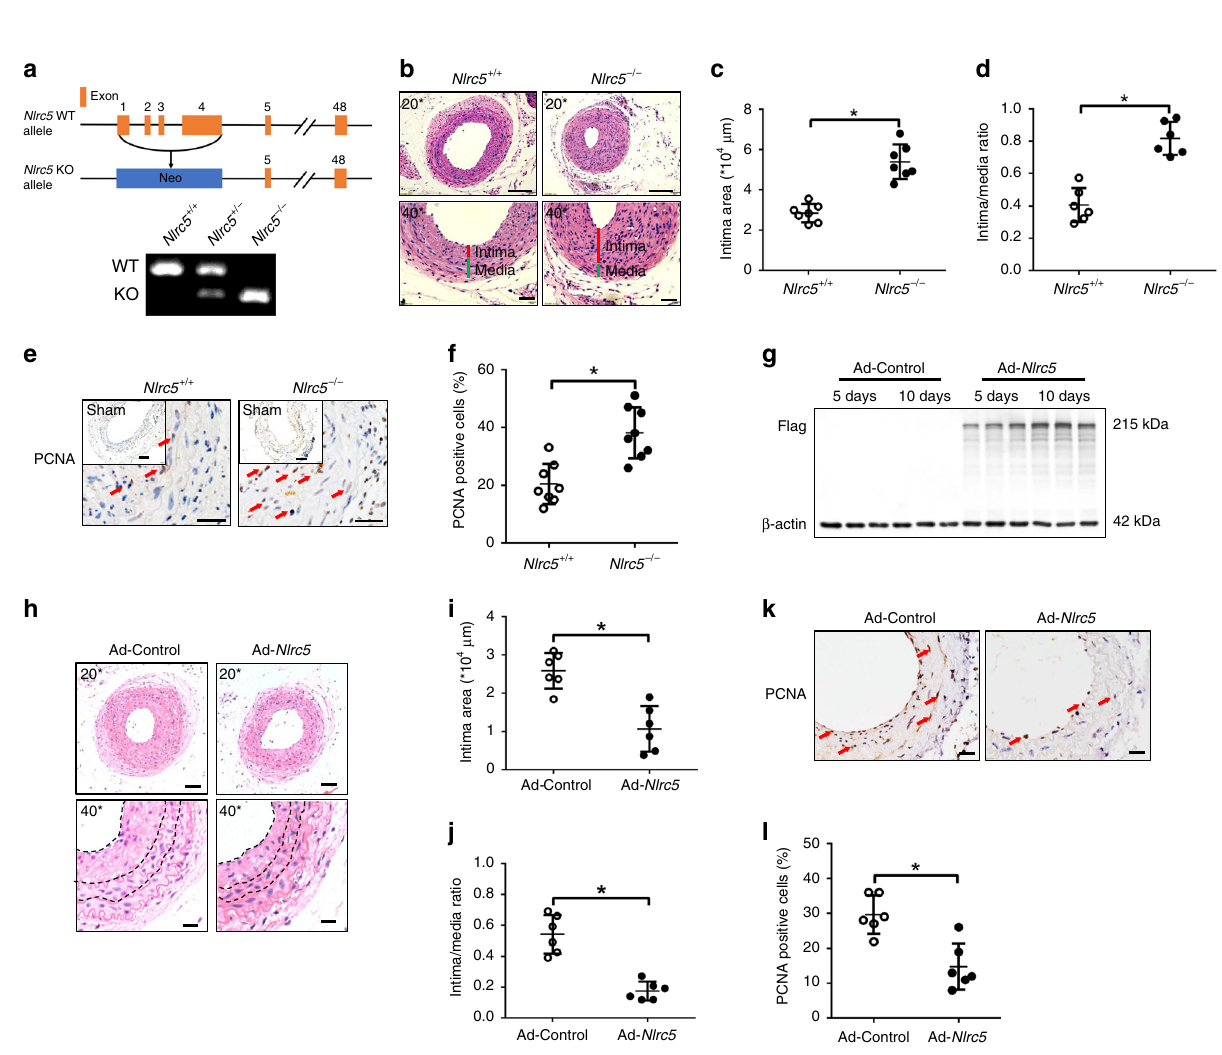
Fig. 1 NLRC5 is upregulated in human coronary plaque and in mouse ligated carotids. a Representative images of hematoxylin/eosin-stained normal coronary artery and coronary plaque. Scale bar: 100 μ m. b Immuno fl uorescence staining shows that NLRC5 (green) is upregulated in vascular smooth muscle cells (VSMCs, stained in red) residing in coronary plaque. Scale bar: 100 μ m (upper) and 20 μ m (lower). c Quantitative analysis of the percentages of NLRC5- positive stained VSMCs in coronary arteries ( n = 3 per group). Five fi elds per section from each sample are analyzed. d Immuno fl uorescence staining shows that NLRC5 (red) is constitutively colocalized with VSMCs (labeled with α -SMA in green) in the neointima layer following carotid ligation. Normal IgG isotype serves as negative control. Scale bar: 50 and 20 μ m. e Quantitative analysis of the percentages of NLRC5-positive stained VSMCs in sham and ligated carotid artery from C57BL/6 mice after 3-week carotid ligation ( n = 5 per group). Five fi elds per section from each sample are analyzed. f , g Western blots show the protein levels of NLRC5 in ligated carotids compared with sham carotids of C57BL/6 mice. The western blots are repeated in three samples after 1-week and 2- week carotid ligation. h NLRC5 is increased in human aortic smooth muscle cells (HASMCs) at indicated time points under PDGF-BB (10ng/ml) stimulation. The western blots are repeated for three times. i NLRC5 is particularly expressed in the nuclei of HASMCs and upregulated in response to PDGF-BB (10ng/ml) stimulation. j Representative immuno fl uorescence staining depicts that NLRC5 (green) is predominantly located in the nuclei (blue) of HASMCs with and without PDGF-BB stimulation. The cytoplasm of HASMC is stained with α -SMA (magenta). Scale bar: 10 μ m. Data are presented as mean±SD. Two-tailed Student ’ s t -test is used to compare two groups ( c , e , and g ), and analysis of variance (ANOVA) followed by Bonferroni post hoc analysis is used to compare three or more groups ( h ). * P <0.05. Original magni fi cation, ×100 ( a and b ), ×400 ( b and d ) and ×630 ( j ). Source data are provided as a Source Data fi le